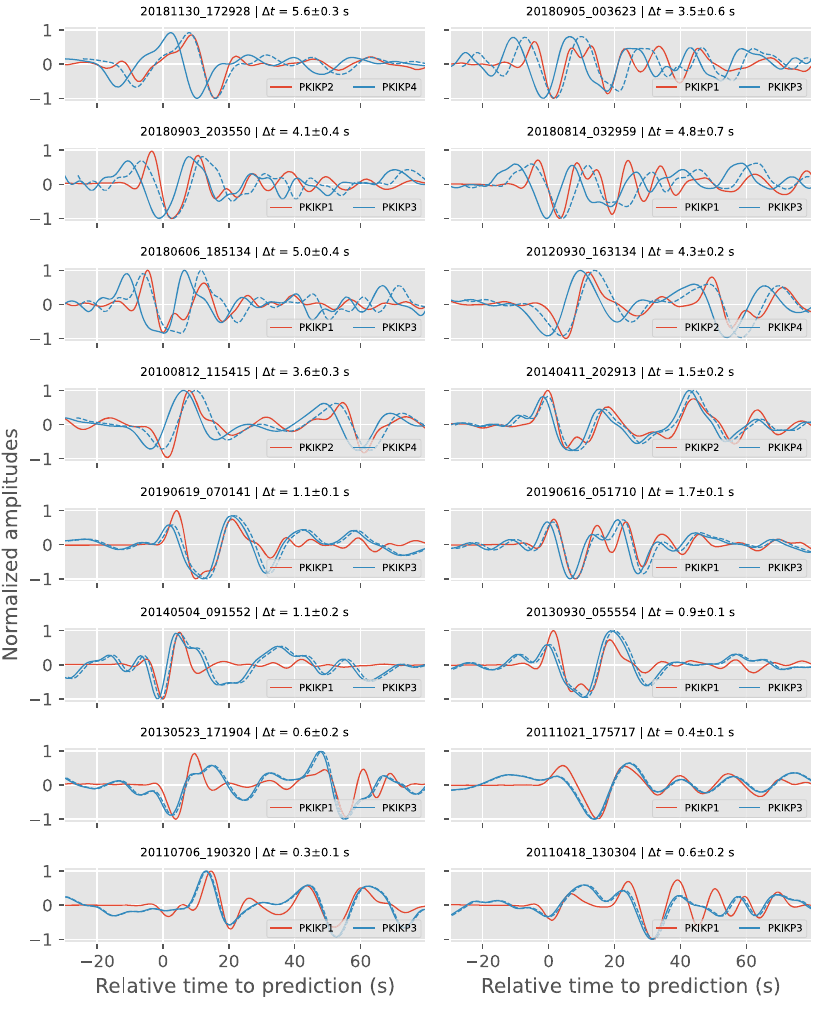
waveforms. Panel titles show the origin times and the measured residuals with bootstrapped